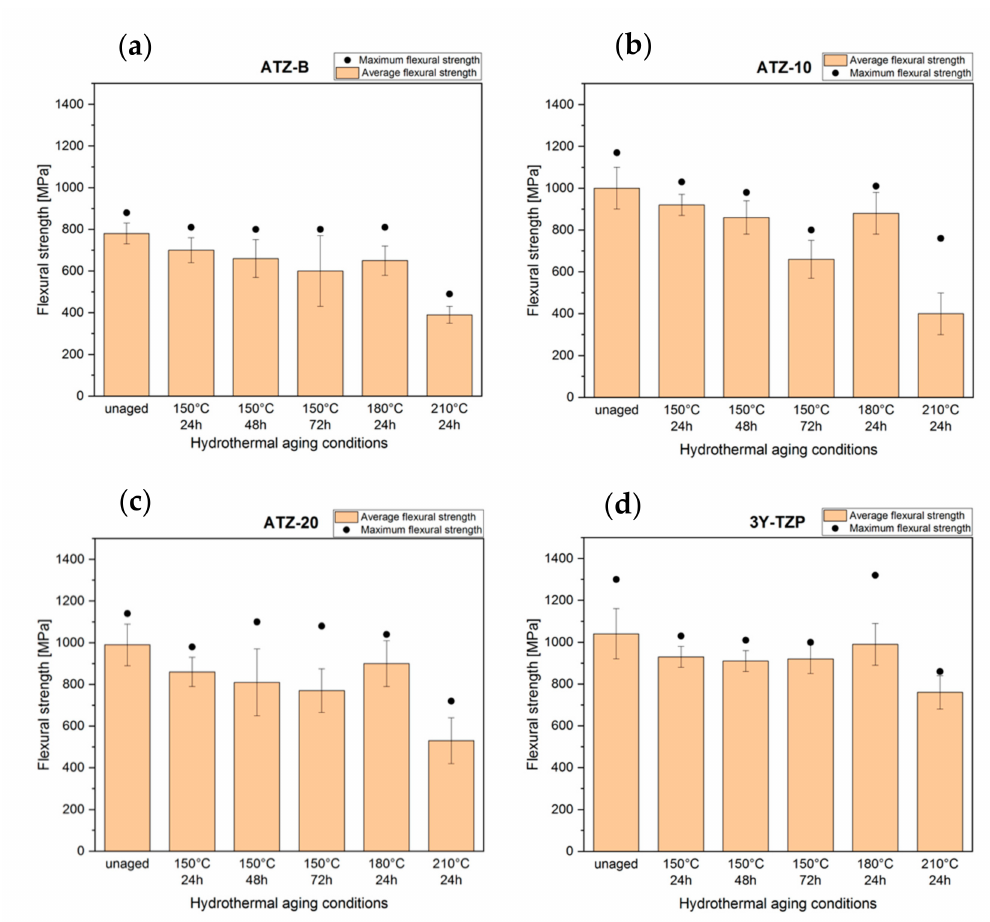
Figure 4. Flexural strength of ( a ) ATZ-B, ( b ) ATZ-10, ( c ) ATZ-20 composites and ( d ) 3Y-TZP reference material before and after aging. Black dots denote the maximum strength values from a given measurement